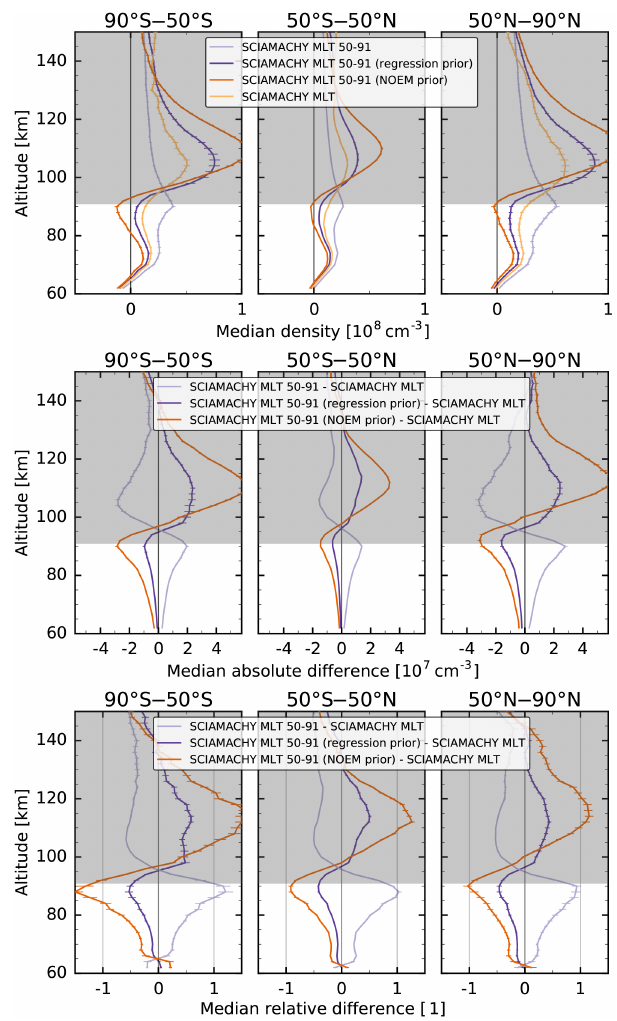
Figure 6. Median of the NO number densities (top) as well as the absolute (middle) and relative (bottom) differences to the full MLT retrieval in three latitude bands. The results are shown for the re- stricted (50–91km) MLT scans without a priori input (light purple), and using the two a priori choices (dark purple is regression model, dark orange is the NOEM model). The number densities from the full SCIAMACHY MLT scans are shown in light